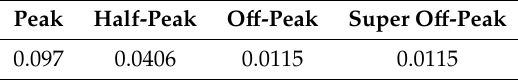
Table 3. Tari ff rate applied in Portugal mainland ( € ).